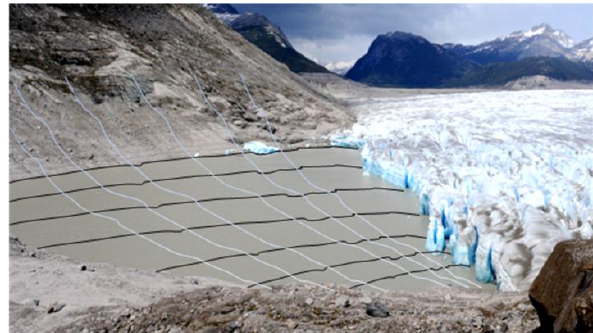
Figure 11. Tracking changes of the lake basin. The water lines can be interpreted as contour lines (level curves)